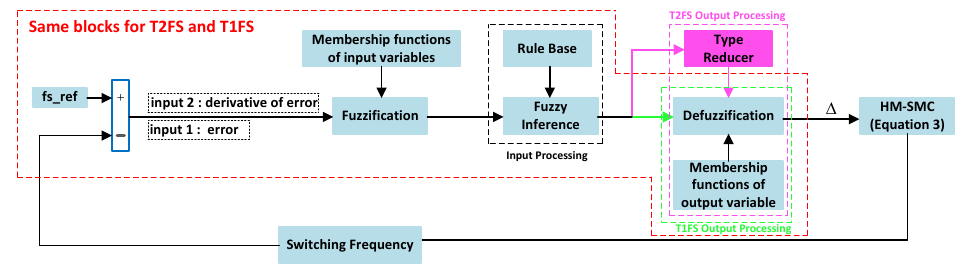
Figure 3. T2FS and T1FS block diagram.